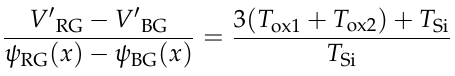
where ∆ φ is the difference between the work functions of the right gate and bottom gates. To simplify the analysis, take T ox1 and T ox2 as 1 nm, and ∆ φ = 0 eV. Equation (2) can be rewritten as: